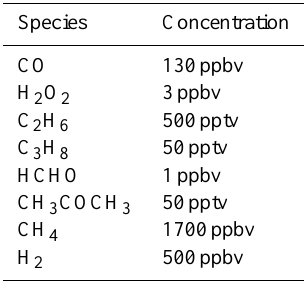
Table 2. Initial concentrations of six species used in the box